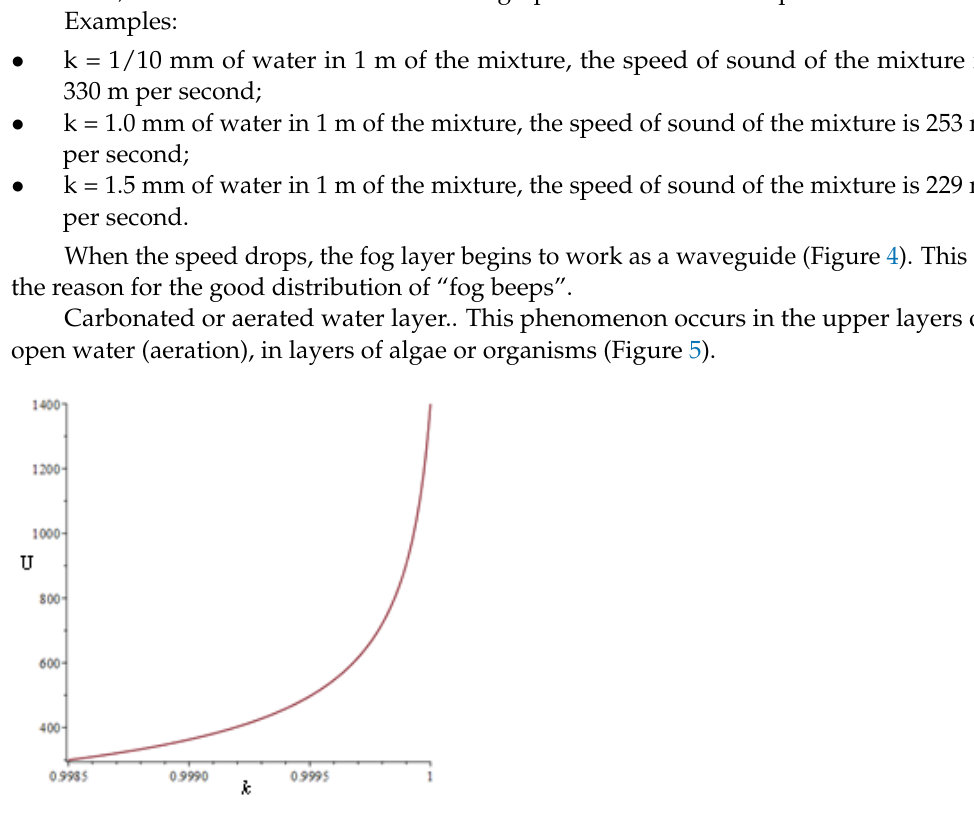
Figure 5. Graph of acoustic velocity versus low air concentrations in water. SI speeds. For low air concentrations in